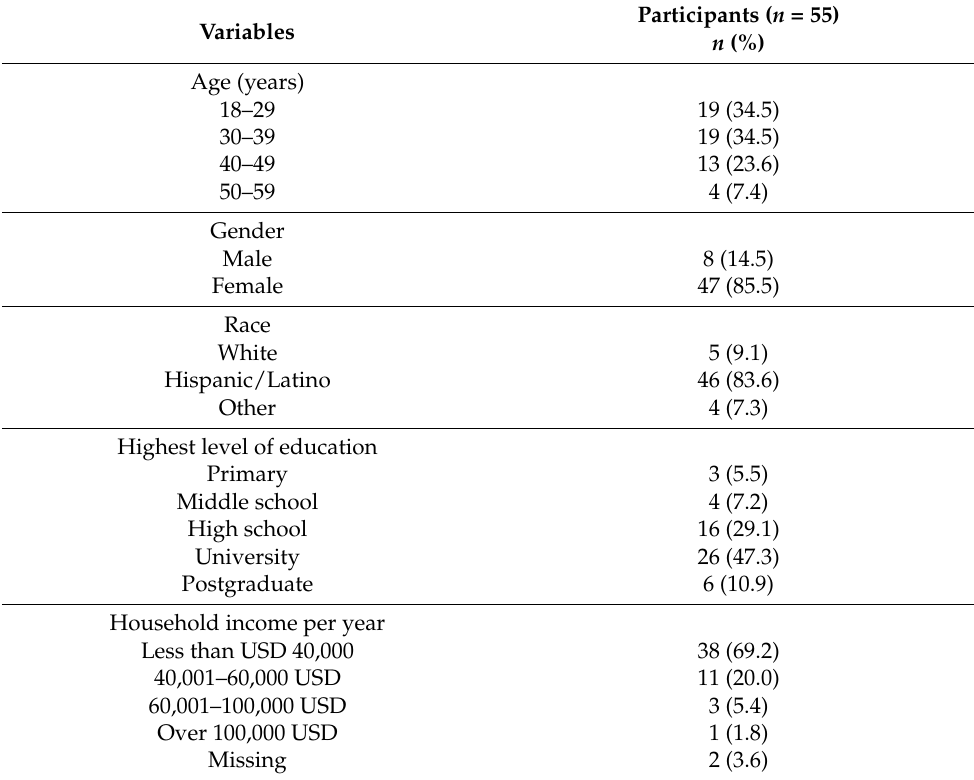
Table 1. Sociodemographic